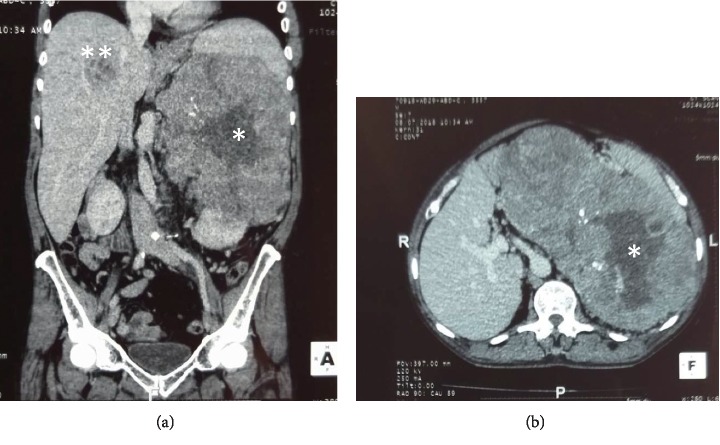
Contrast-enhanced CT abdomen, chest, and pelvis: (a) coronal image and (b) axial image showing heterogeneously enhancing left suprarenal mass (21 × 18 × 24 cm)∗ with central necrosis and foci of calcifications. Focal liver metastasis∗∗ is also seen.